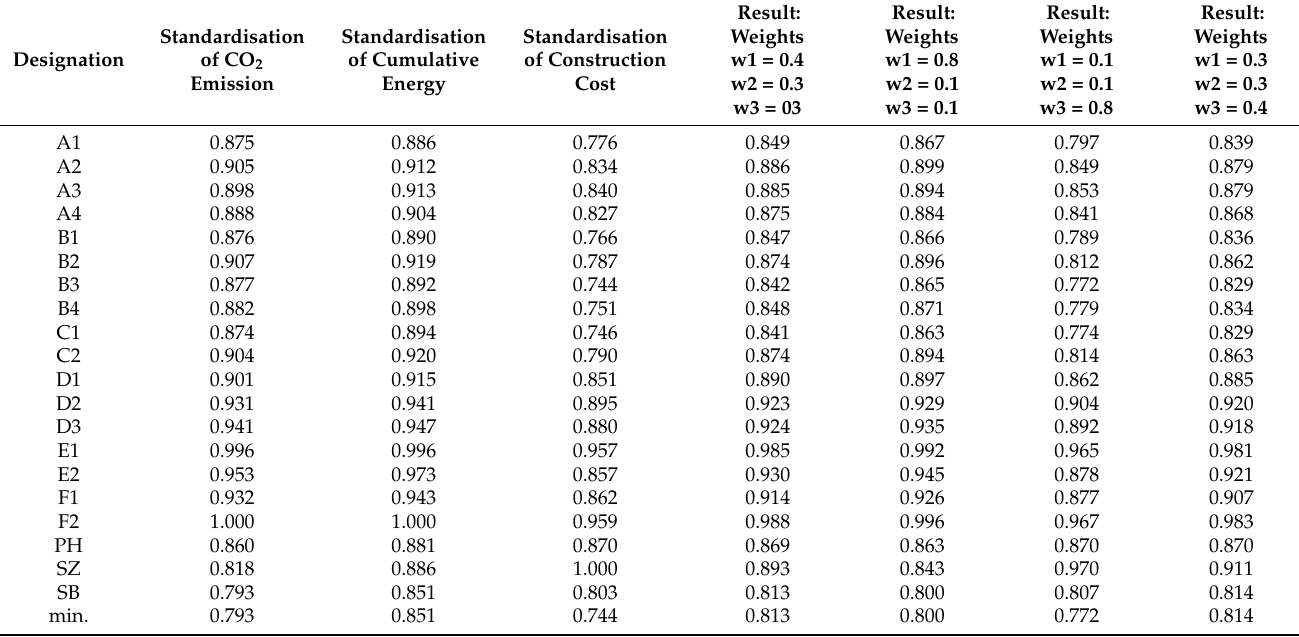
Table 8. Results of multi-criteria optimisation by weighted sum method for 5 sets of